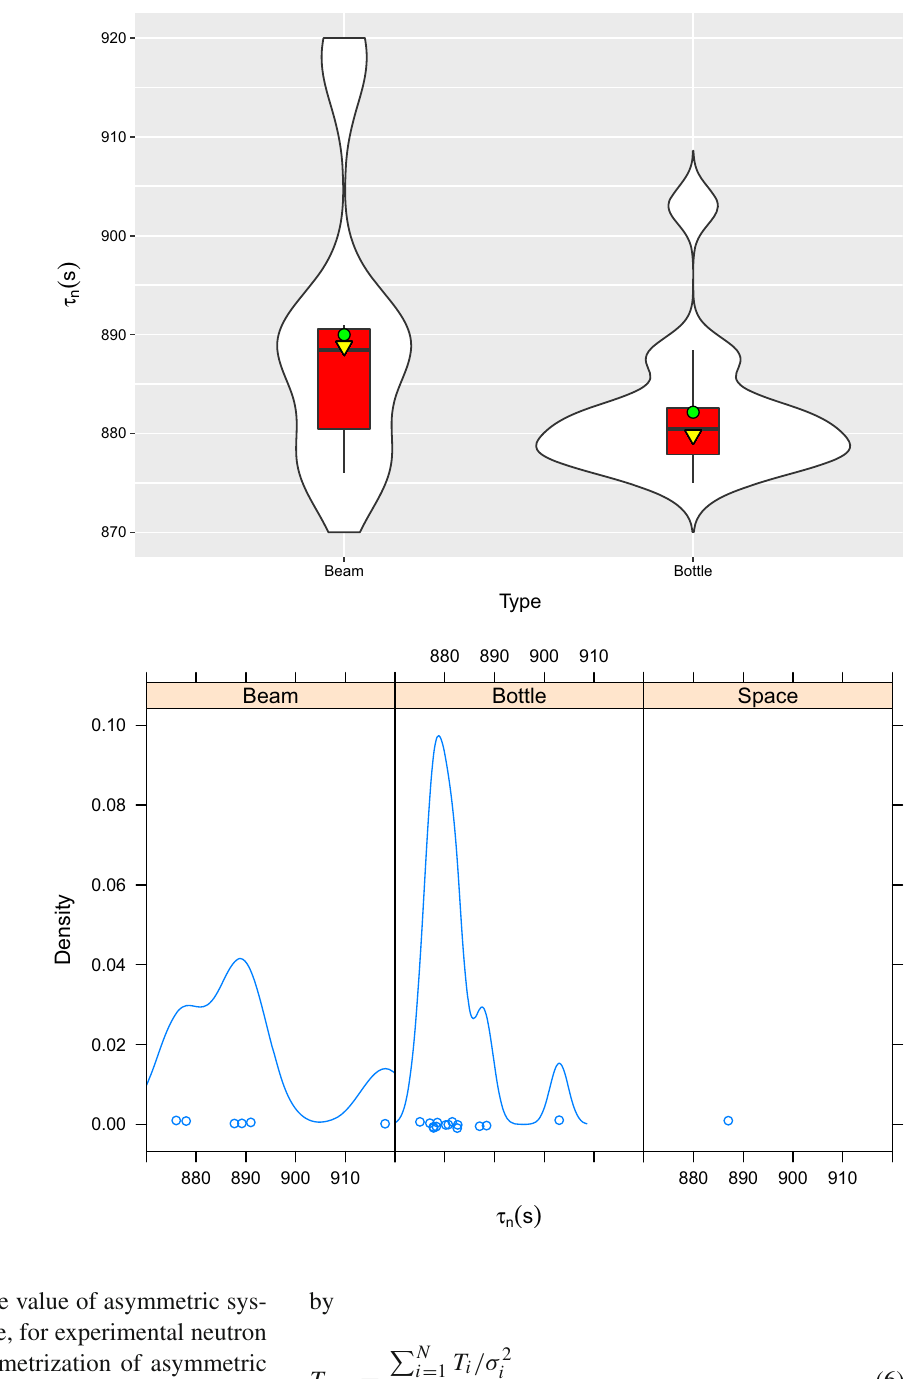
Fig. 4 Violin plot of neutron lifetime measurements. The MFV and average values from different methods are indicated by the inverted triangles and circles, respectively, while the horizontal solid lines in boxes illustrate the median